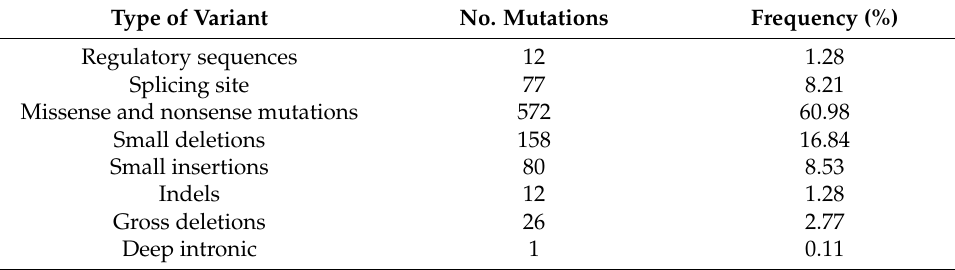
Table 2. Types of Known Variants in ATP7B and its Frequency 1 .